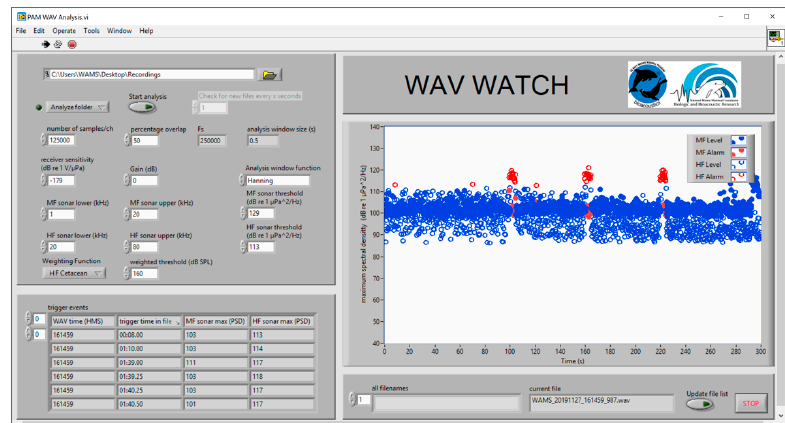
Figure 8. The LabVIEW-based module that evaluates the previous five minutes of data recorded using WAMS for spectral levels that exceed a user defined threshold and are weighted by the high-frequency cetacean weighting curve function [16]. The blue dots indicate a level less than the user-defined threshold (i.e., Mid-Frequency (1–20 kHz) set at 129 dB re 1 μ Pa 2/ Hz; High-Frequency (20–80 kHz) set at 113 dB re 1 μ Pa 2/ Hz), and a red dot would indicate a sound source that is at a level louder than the threshold. If the dot is an open circle (red or blue) it is measuring the signal in the high frequency range, if the dots are closed (red or blue) it is measuring the signal in the mid-frequency range.